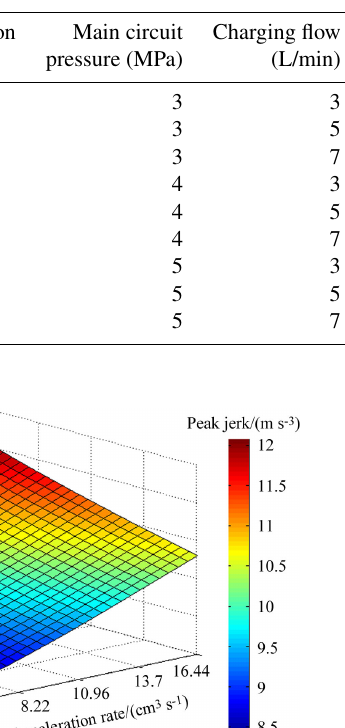
Table 6. Simulation scheme based on the L9(3 4 ) orthogonal table.